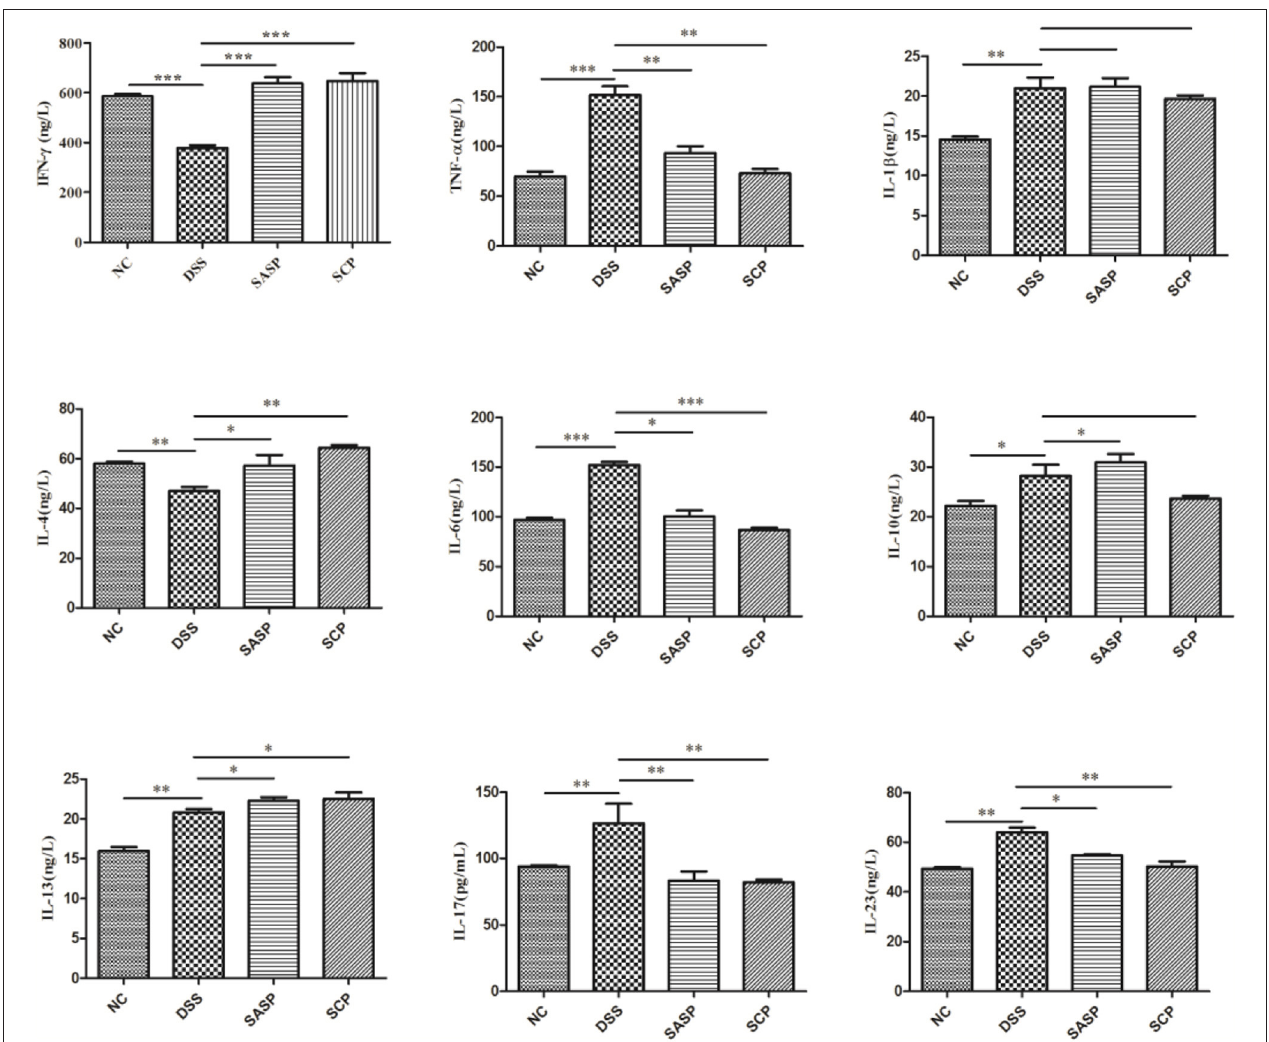
FIGURE 4 | Levels of inflammatory cytokines. NC, control group; M, DSS group; SASP, positive drug group; SCP, S. chinensis polysaccharide group. Data are expressed as means ± S.D. * p < 0.05, ** p < 0.01, *** p <